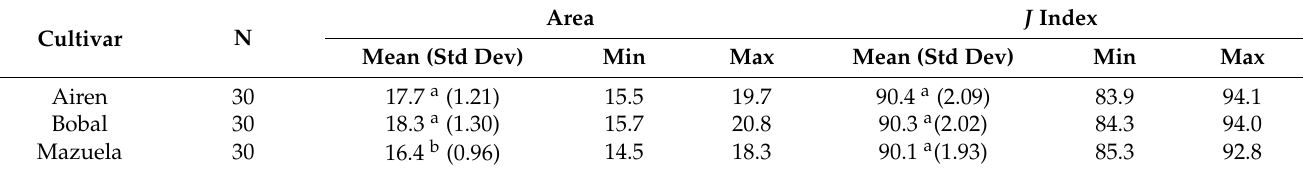
Figure 20. From left to right: A sum of the silhouettes of 30 seeds, a silhouette obtained by the pixel profile of the first image, Air é n the model, and four representative seeds of Air é n. Bar represents 1 cm. Table 11. Values of area and J index in the cultivars of the Airen group. Superscript letters indicate the results of Tukey test: the mean values marked with the same letter in the superindex of each column do not differ significantly at p < 0.05. N is the number of seeds analyzed.